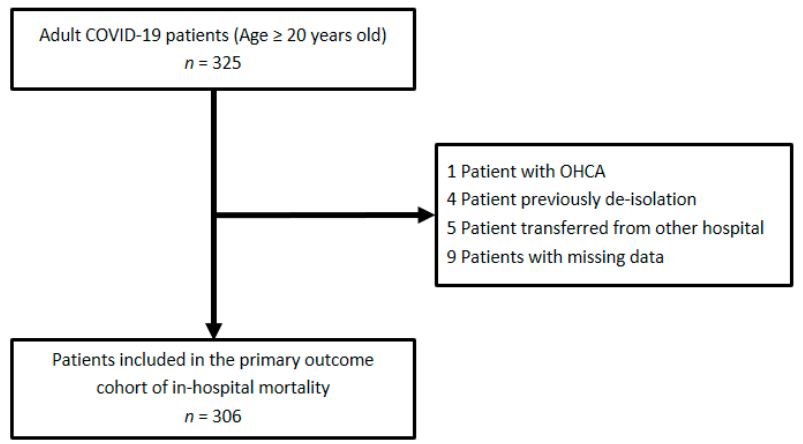
Figure 1. Flowchart of patients included in the study cohort. Abbreviation: OHCA: out-of-hospital cardiac arrest. Table 2. Demographic characteristics and initial vital signs at triage of COVID-19 patients in the study